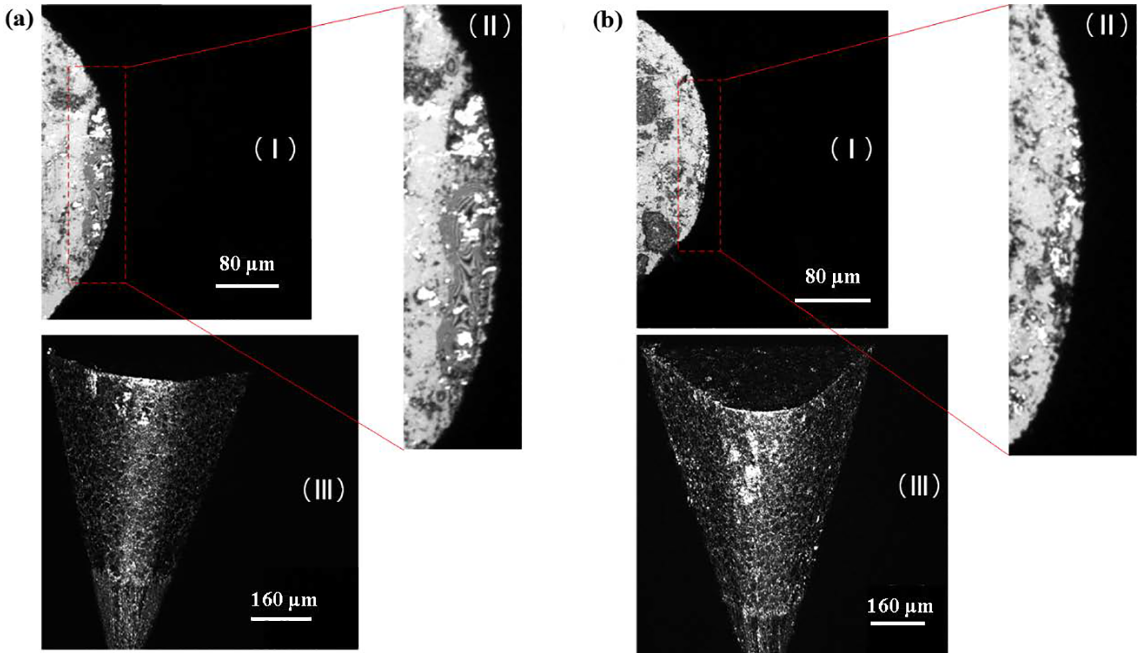
Figure 6. SEM micrographs of tool wear. (a) SEM micrographs of tool using 2-D EVC. (I) Top view of tool tip. (II) Partial enlarged detail of tool tip. (III) Front view of tool. (b) SEM micrographs of tool using 3-D EVC. (I) Top view of tool tip. (II) Partial enlarged detail of tool tip. (III) Front view of